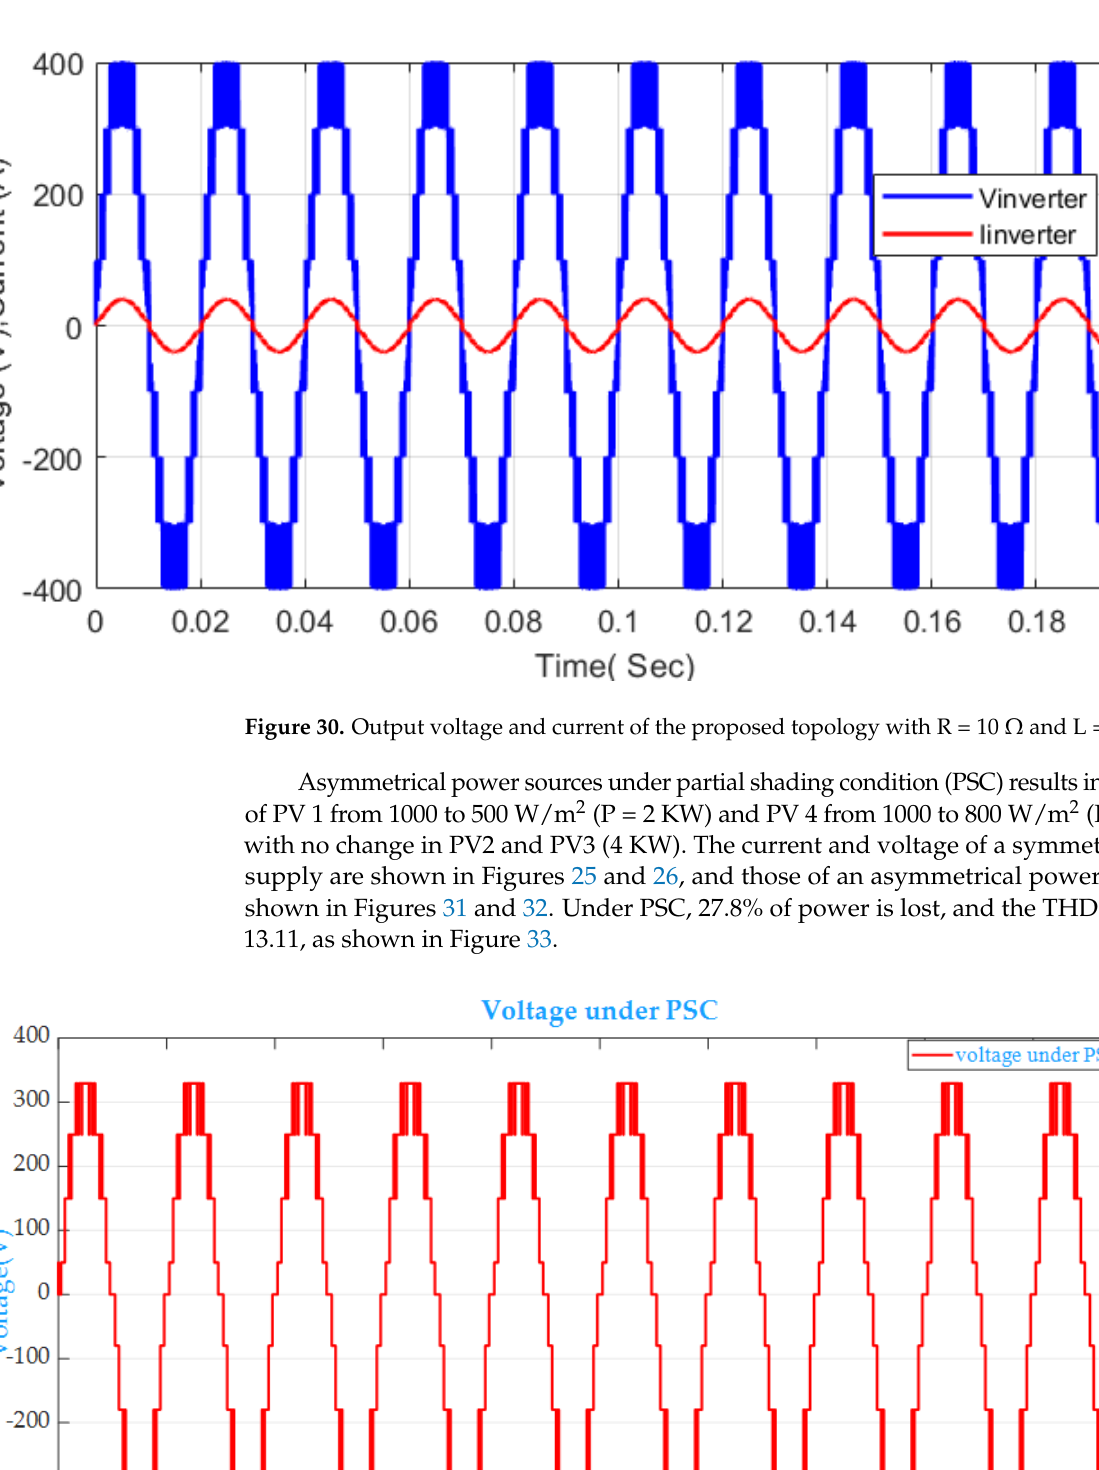
Figure 29. FFT spectrum of the output voltage after filtering.